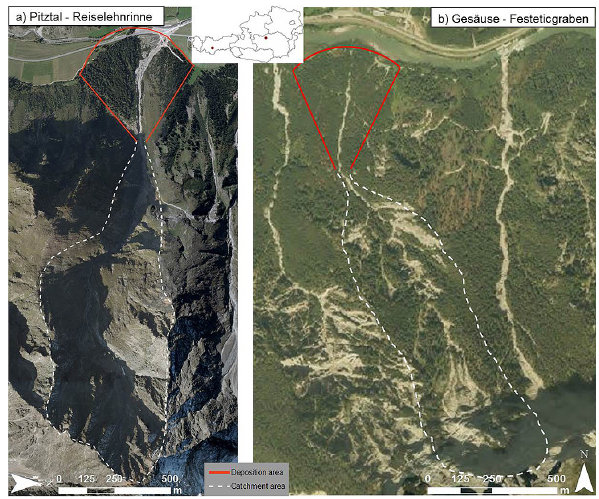
Figure 1. (a) The Reiselehnrinne Creek in the Pitztal study area in the western part of Austria, and (b) Festeticgraben Creek (source aerial photo: GIS-Steiermark, 2013) in the eastern part of the Aus- trian Alps. The catchment areas (white dashed lines) are defined as the source zones and deliver material to the fans (red solid